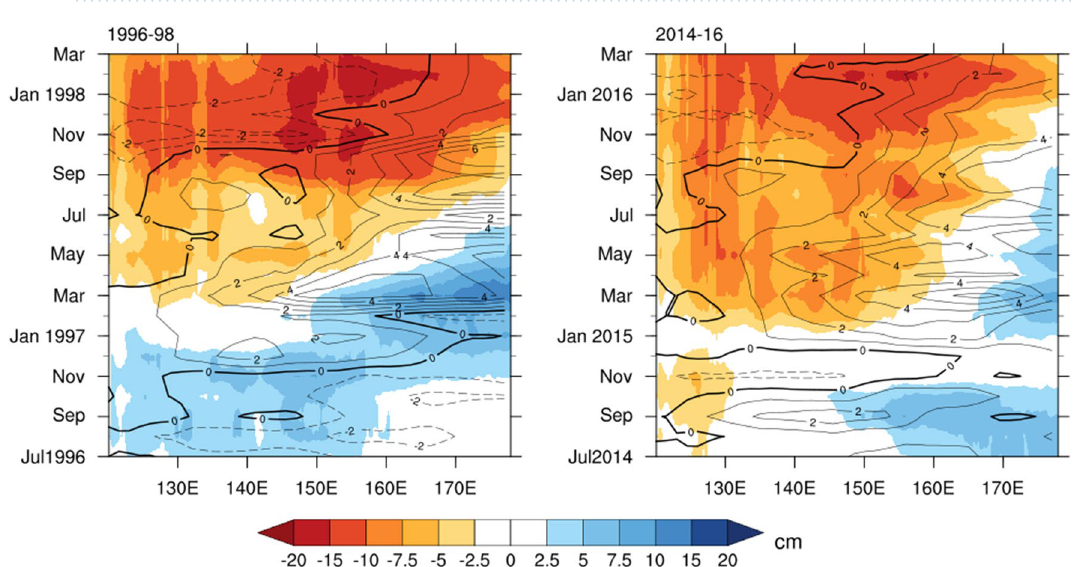
Figure 6. Time-longitude plot of BRAN sea level height (shaded, cm) and ERA-interim surface zonal wind 1 (contours, m s − ) anomalies averaged between 5 ◦ S and 5 ◦ N for two El Niño events during 1996–1998 and 2014–2016, respectively. Plots are generated using the NCAR Command Language version 6.6.2 (http:// www. ncl. ucar.